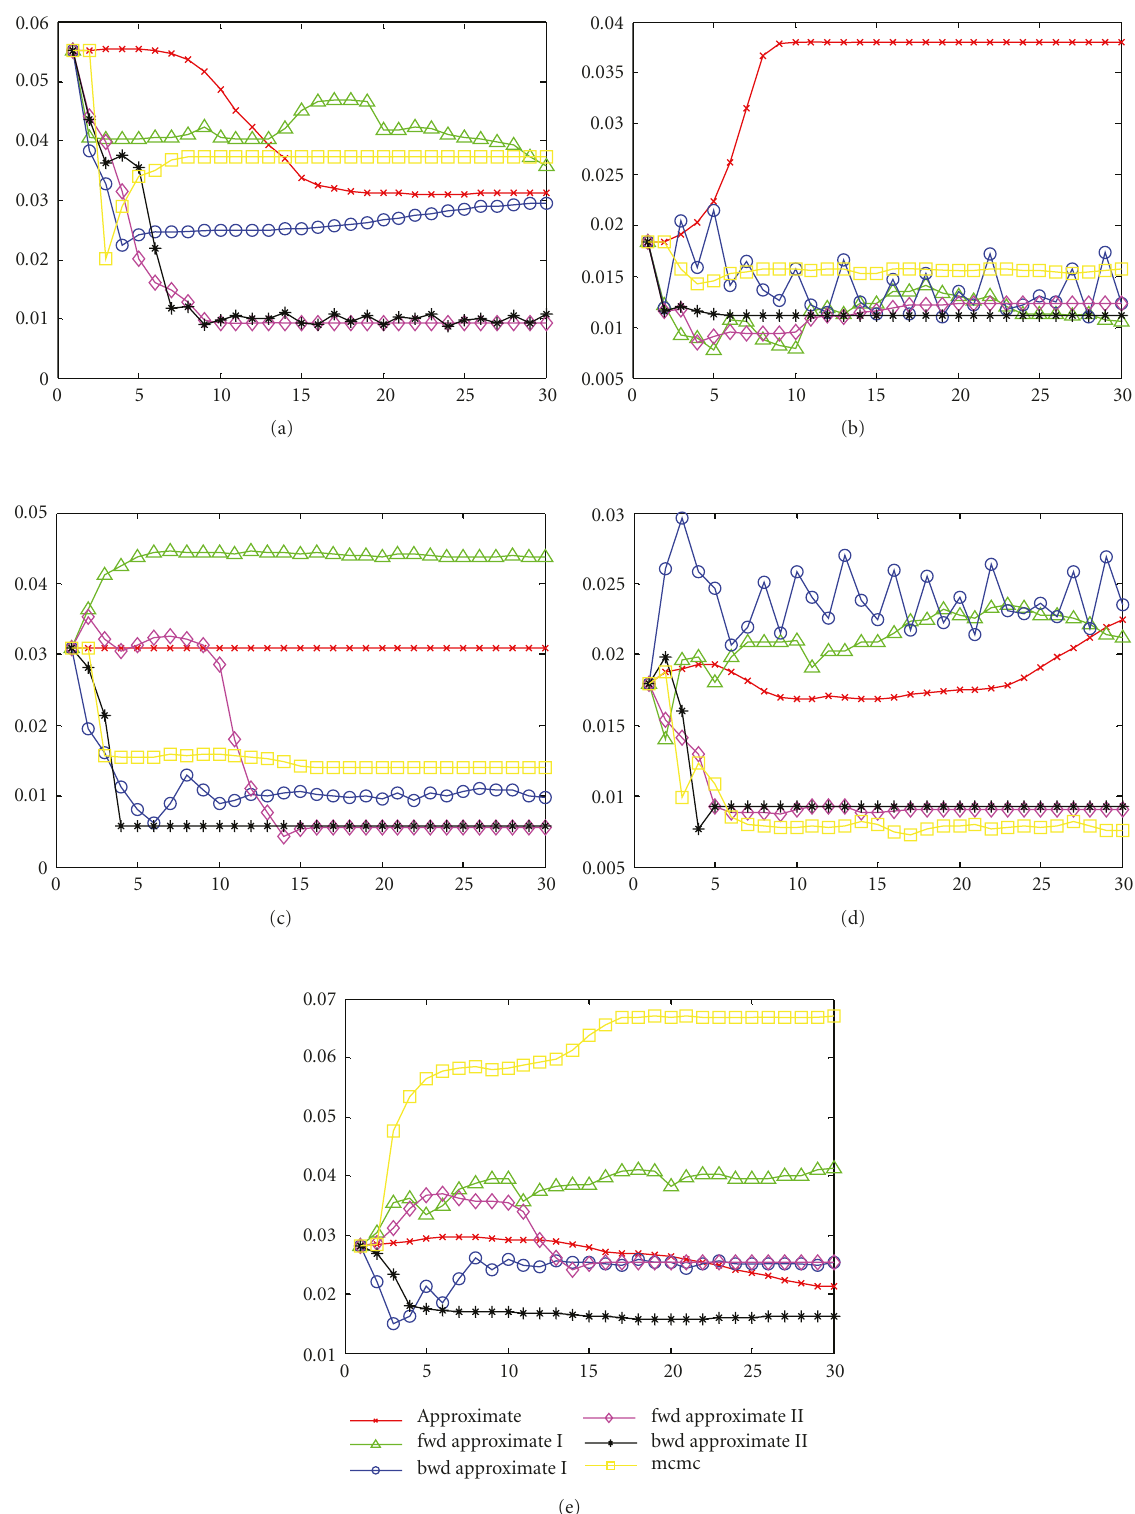
Figure 15: Learning curve of EM with di ff erent inference algorithms. X -axis corresponds to the index of EM iterations; Y -axis corresponds to the Euclidean distance in the channel normalized space [32] between the estimated and true appearance mean. (a)–(e) corresponds to person A to E,